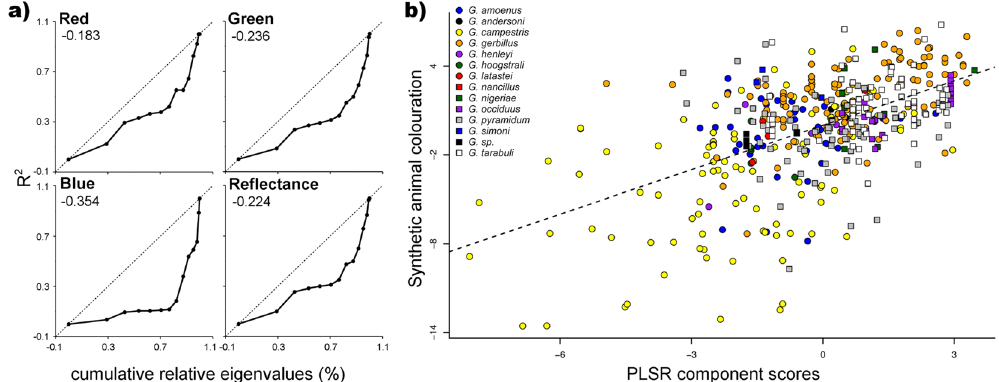
of the colour inheritance is due to genetic mechanisms related to the expression of few colour genes (e.g. the well-known: Melanocortin-1 receptor and its antagonists Agouti signaling protein) 52, 53 . But camouflage is present in both brightening-constrained ( G . campestris ) and darkening-constrained ( G . gerbillus and G . occiduus ) species and in both relatively bright ( G . gerbillus and G . occiduus ) and dark ( G . campestris ) species (Fig. 2a). This and the continuous character of variation of coat colour (Fig. 2b) suggest that beside a few important genes, multigenetic (and epigenetic) regulatory mechanisms can be responsible for observed variation, that could facilitate adaptive evolution 24, 54 . The relative importance of environment and phylogeny suggests that environmental mechanisms are more essential in shaping colouration, at least in some parts of the Gerbillus phylogeny. The phylogenetic inertia explained around 9.6% of variation in fur colouration, compared to the 16.8% of inter-specific variation explained by habitat structure. Similar pattern is expected in traits with high genetic variation and little linkage